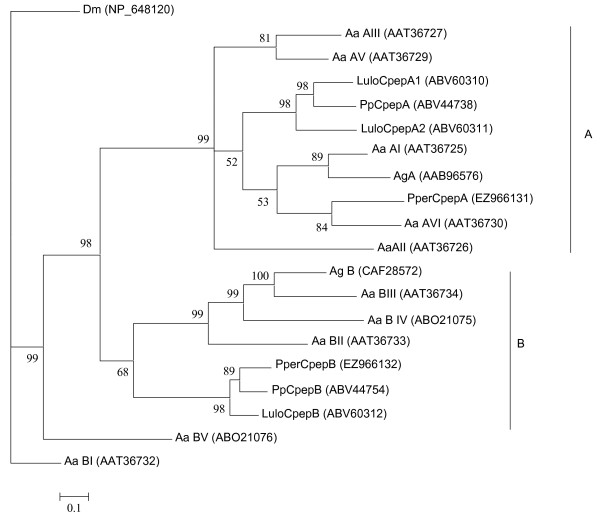
Phylogenetic analysis of putative carboxypeptidases from Drosophila melanogaster (Dm), Aedes aegypti (Aa), Anopheles gambiae (Ag), Phlebotomus perniciosus (Pper), Lutzomyia longipalpis (Lulo) and Phlebotomus papatasi (Pp). Genbank accession numbers are given in parentheses and node support is indicated by the bootstrap values.